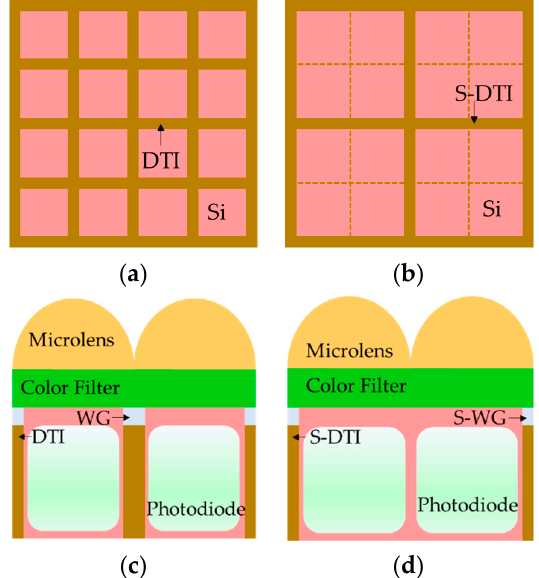
Figure 2. Pixel structures with deep trench isolation (DTI) and tungsten grid (WG): ( a ) Top view of the silicon with DTI. The DTI has located each pixel; ( b ) Top view of the silicon with spatial deep-trench isolation (S-DTI). The S-DTI has located four pixels; ( c ) 2D cross-section of pixels with DTI and WG; ( d ) 2D cross-section of pixels with S-DTI and S-WG.